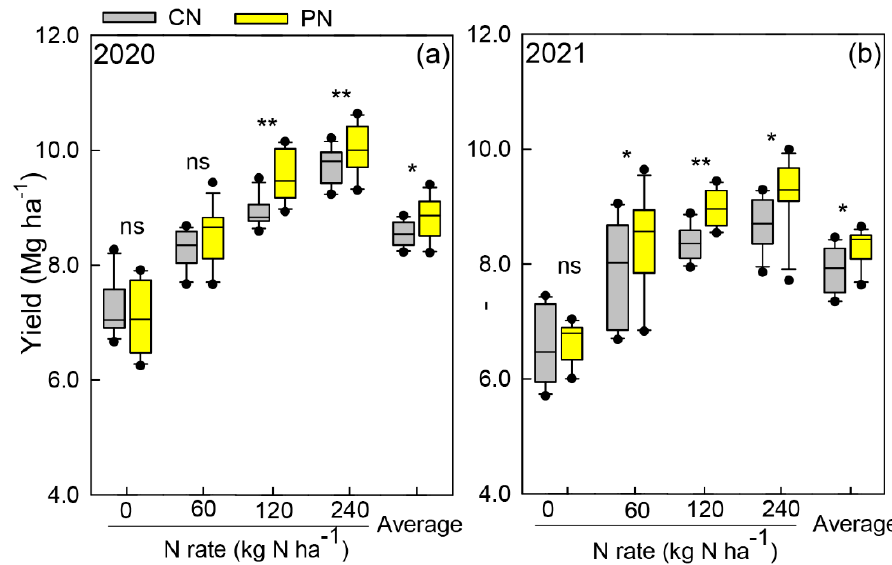
Figure 1. Sorghum yield at 0–240 kg N ha − 1 nitrogen application rates under the control treatment (CN) and polyaspartic acid-coated urea (PN) in 2020 ( a ) and 2021 ( b ). * and ** represent a significant difference between CN and PN at the same N rate at the 0.05 and 0.01 levels, respectively, and ns represents no significant difference.